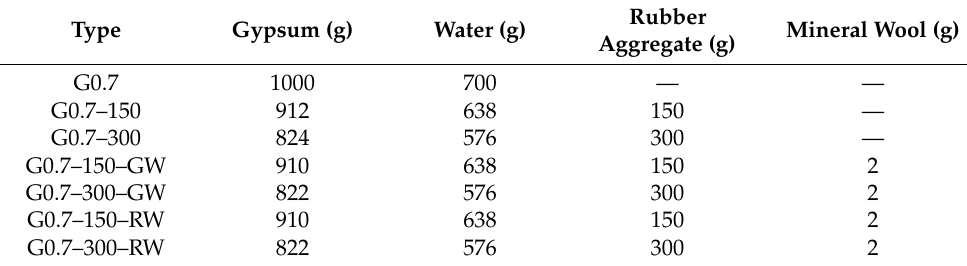
Table 4. Mass ratios used for sample preparation.